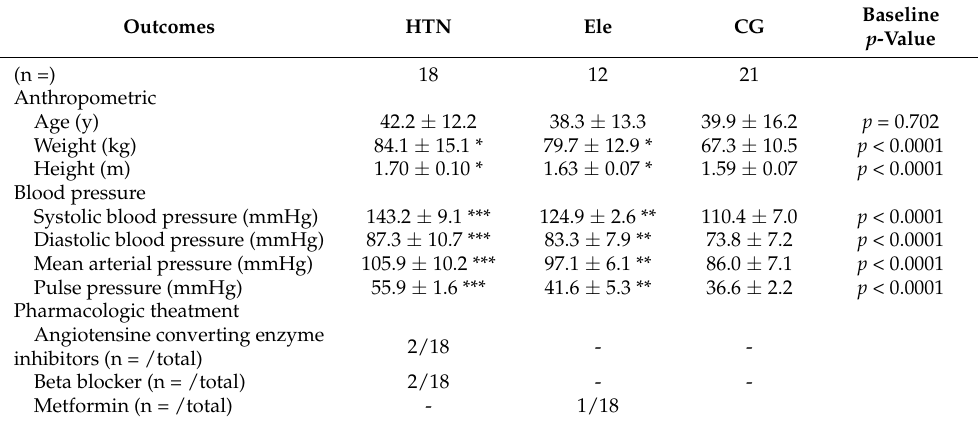
Table 1. Baseline characteristics of three adult groups of different blood pressure control participants of a progressive volitional cycling